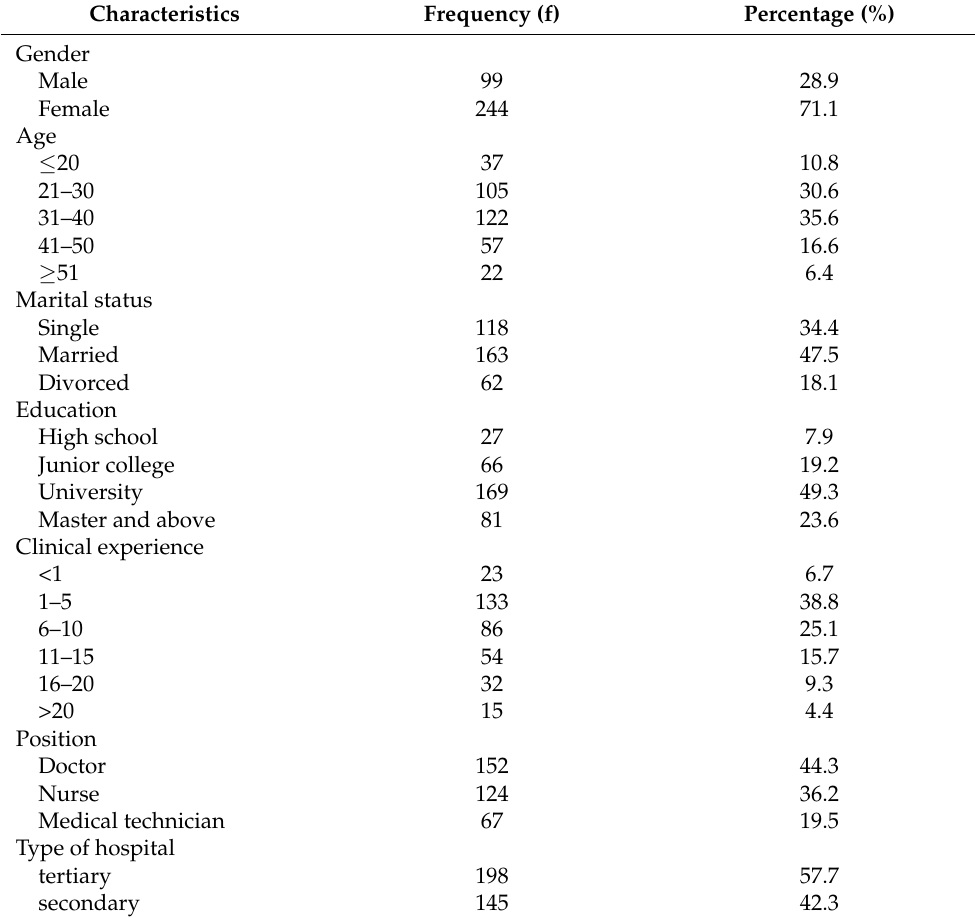
Table 2. Demographic characteristics for the participants (N =